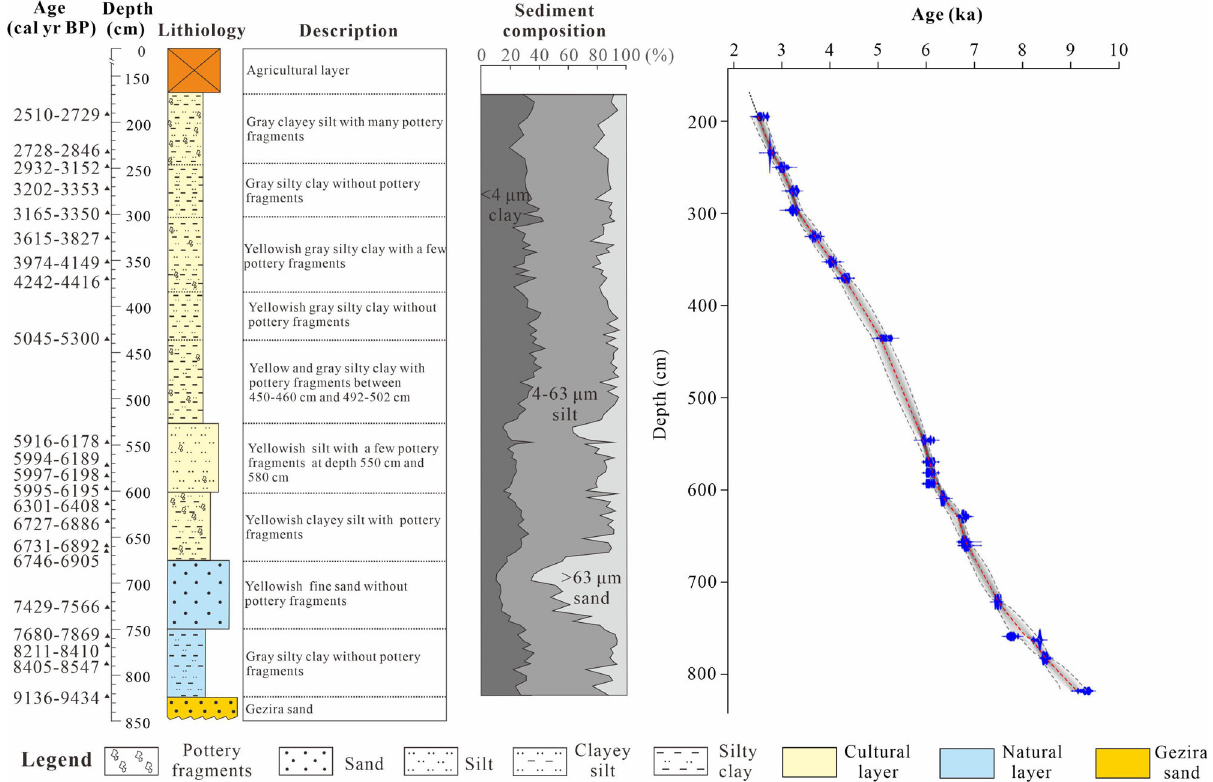
Fig. 2 Lithology description and age-depth model of core SH-1. Lithology and age-depth model of core SH-1 from archaeological site Sais (see Fig. 1a). 22 AMS- 14 C dates from SH-1 form the basis of this high-resolution study (the envelop of age-model represents the range between minimal and maximal dating value at fi nal 95% con fi dence intervals). The “ natural layer ” (without pottery and sherds) and the “ cultural layer ” (with pottery and sherds) are shown in the core log. The basal sand layer of SH-1 is termed as “ Gezira ” (Turtleback) in Arabic. Sediment log SH-1 was modi fi ed from our previous study 37